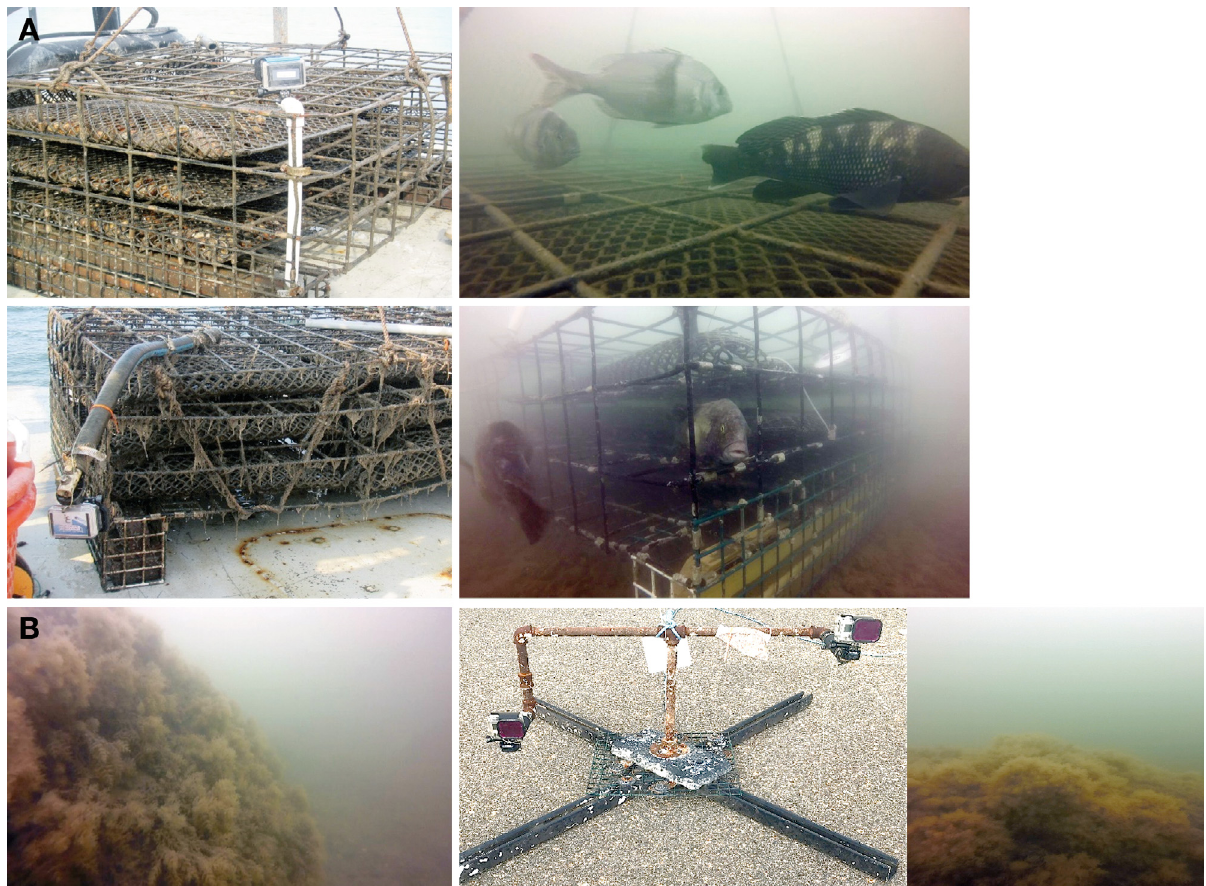
Fig. 2. Camera deployment and example video frames. (A) Two cameras were directly attached to the shelf-and-bag style oys- ter aquaculture cages; one showed images across the cage top, the second showed 2 sides of the cage and the cage−seafloor interface. (B) Two cameras were attached to minimal-structure ‘T-platform’ stands that were deployed adjacent to boulders on a rock reef; one showed images across the boulder top, the second showed the boulder side and boulder−seafloor